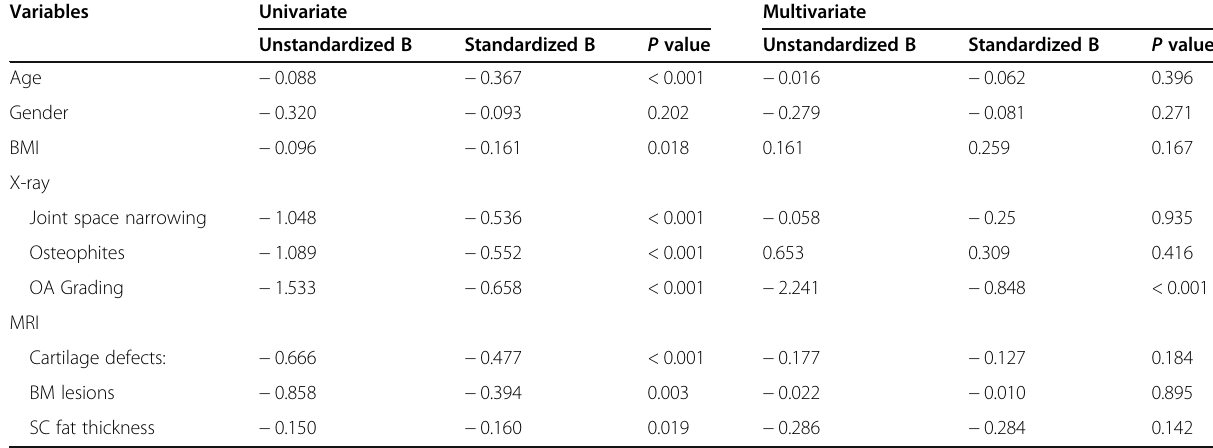
Table 5 Univariate vs multivariate regression model of the IPFP area and patient demographics as well as individual manifestations of OA